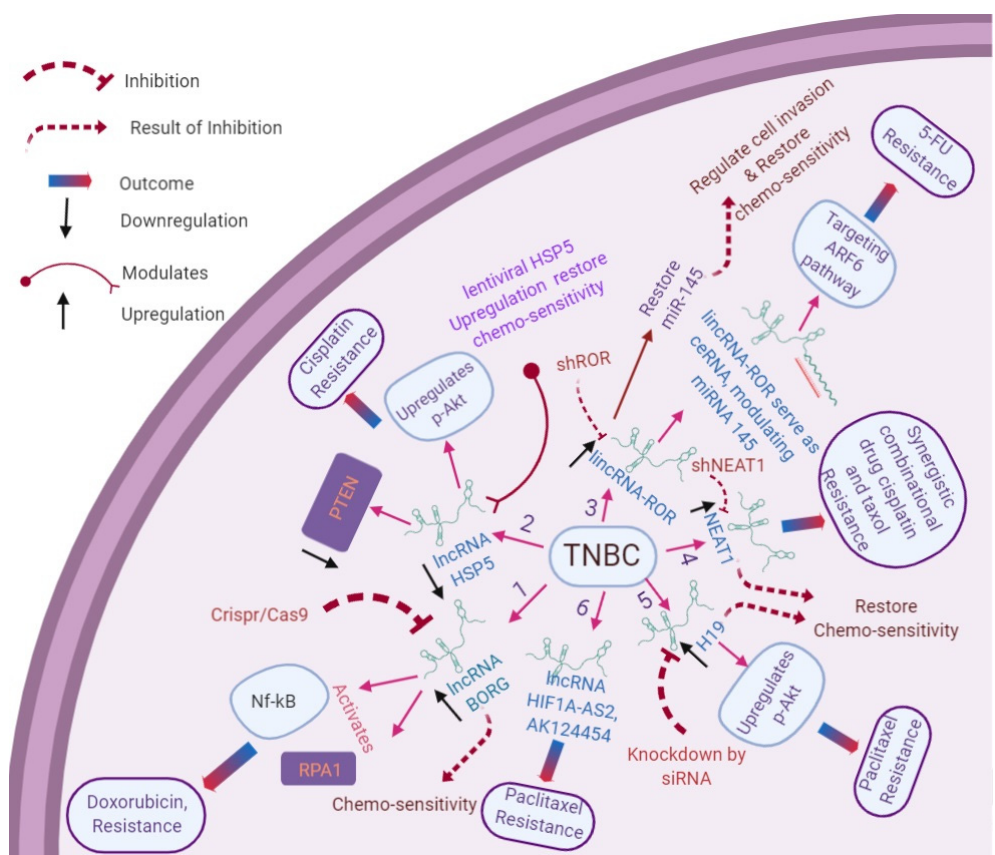
Figure 2. Role of lncRNAs in the drug resistance of triple-negative breast cancer (TNBC). (1) LncRNA BORG (BMP/OP-Responsive Gene) activates NF- ĸ B [56], and RPA1 signaling is responsible for doxorubicin resistance; the modulating BORG expression restores chemosensitivity in TNBC. (2) LncRNA HSP5 downregulates PTEN and upregulates p-AKT expression, which is directly